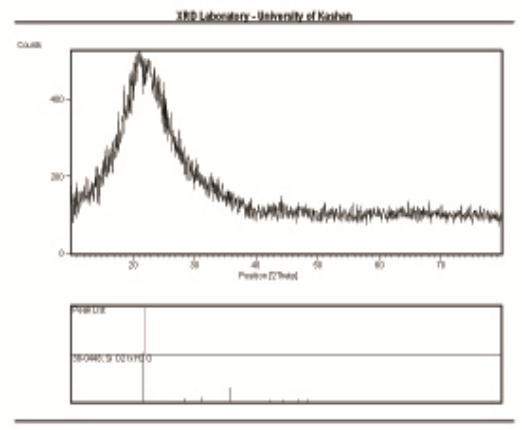
Fig. 1. The XRD pattern of nano SiO